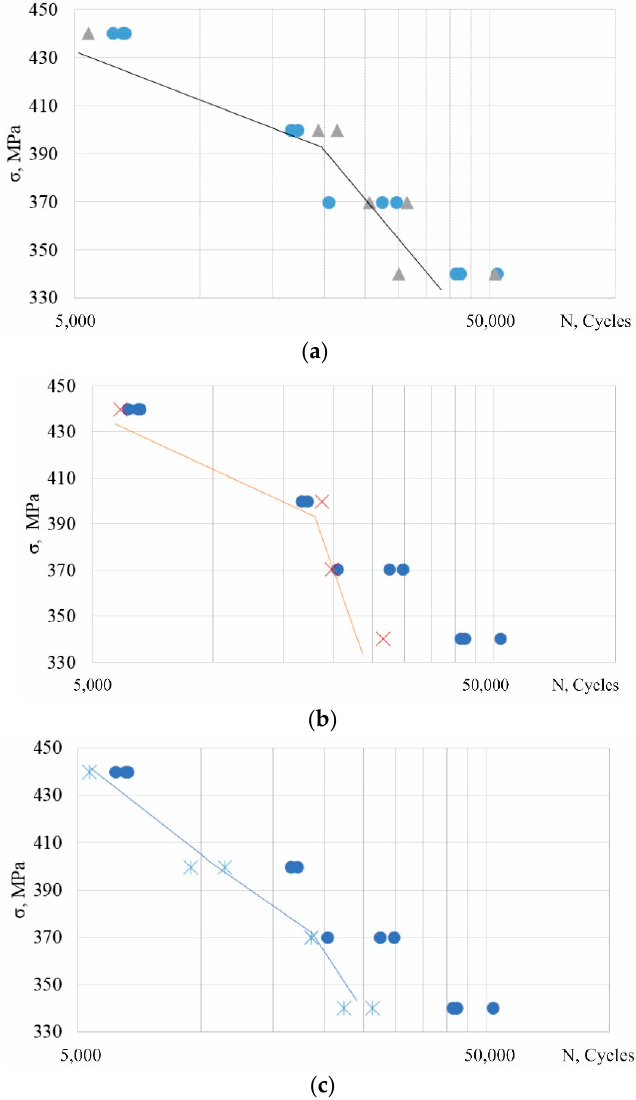
Figure 5. Cyclic durability of alloy D16ChATW in the initial state ( ) and after DNP: ( a ) ε imp = 3.7%( ); ( b ) ε imp = 5.4%( ); ( c ) ε imp = 7.7% ( ).